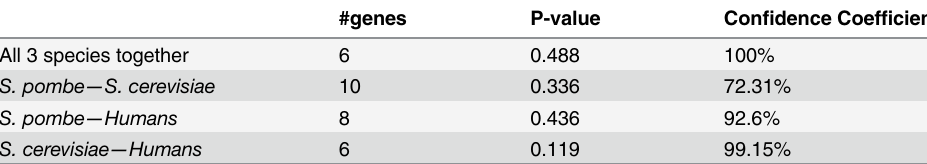
Table 2. Summary of the 4